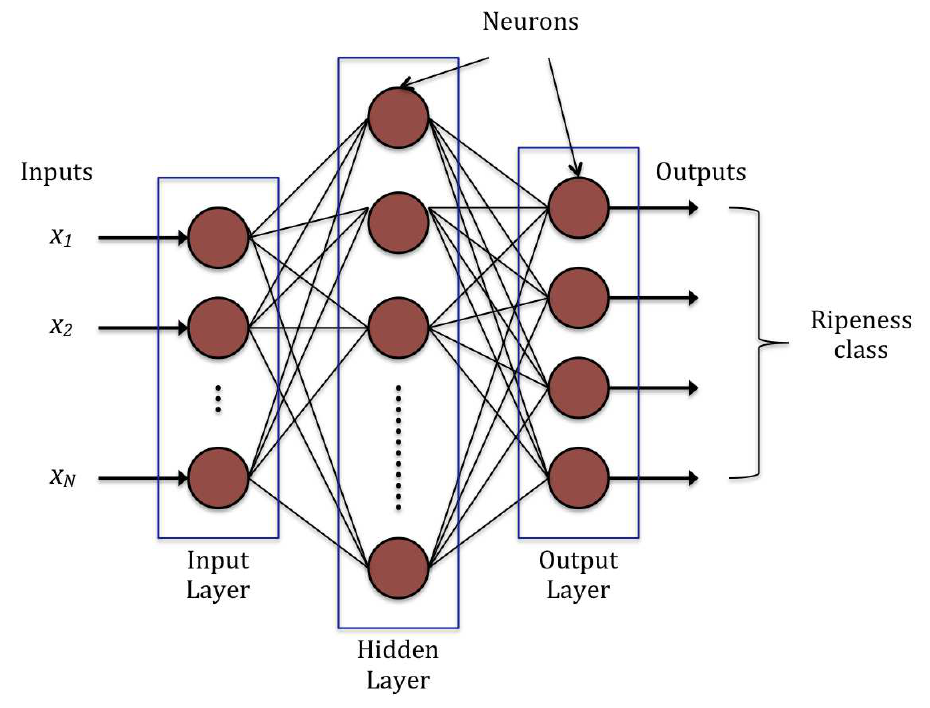
Figure 4. Structure of MLP neural